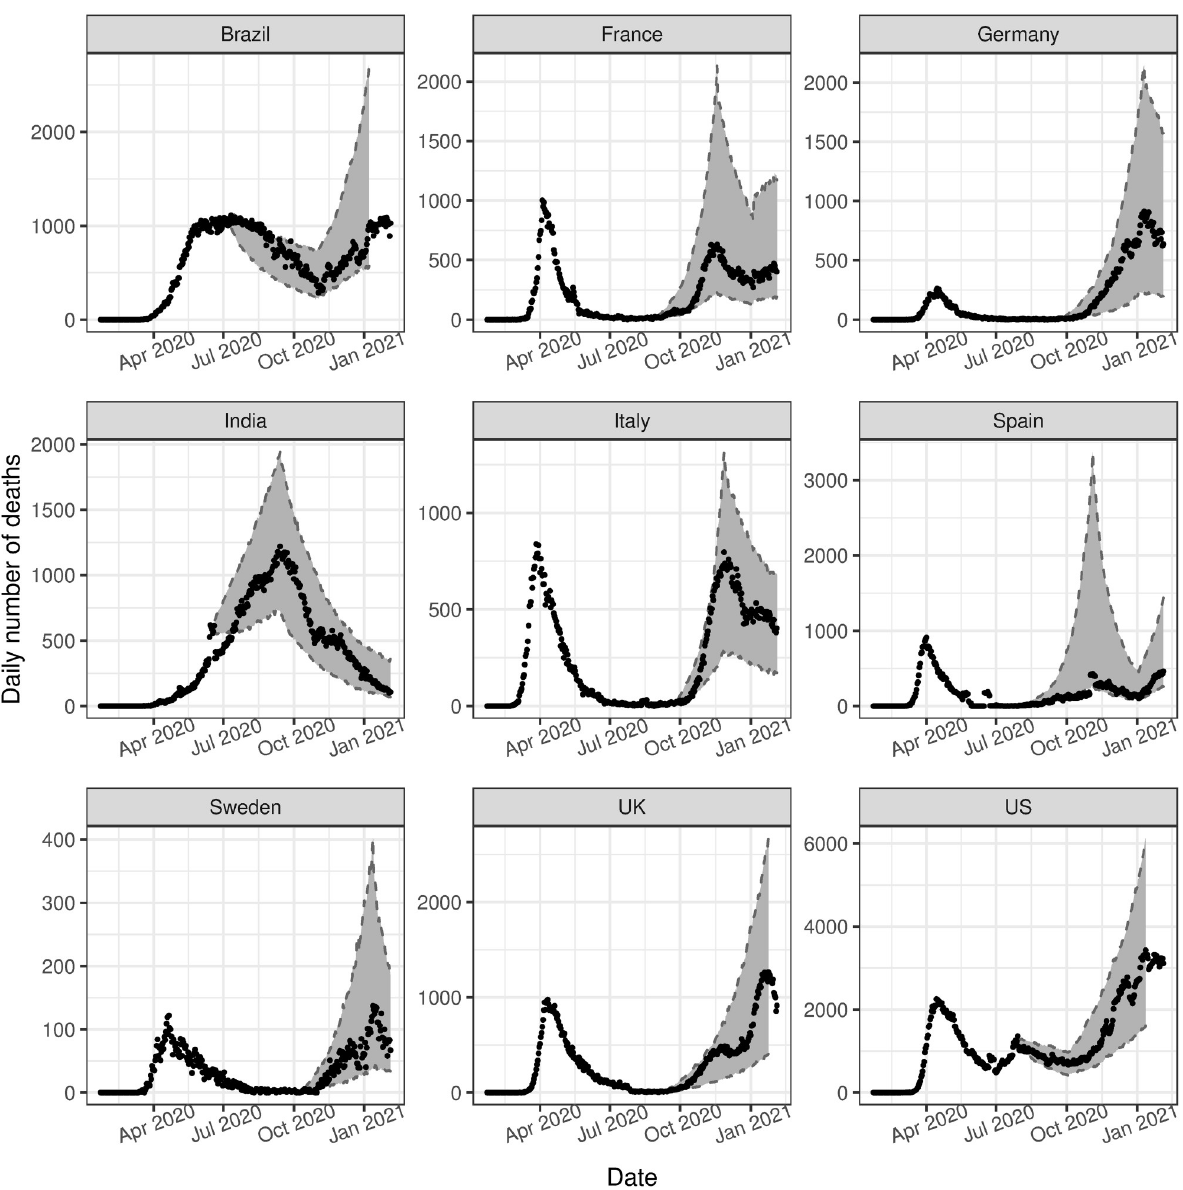
Fig 7. In-sample validation for subsequent analysis, conditioned on data from the initial analysis. The observed number of deaths (black dots) compared to the 95% posterior predictive interval for the estimated expected number of events, i.e. λ ( t ) (grey ribbon), for the subsequent analysis.